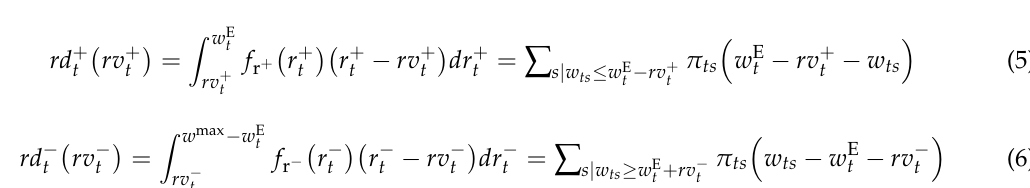
Figure 4. ( a ) The PDF of the SPUR requirements; ( b ) The PDF of the SPDR requirements.